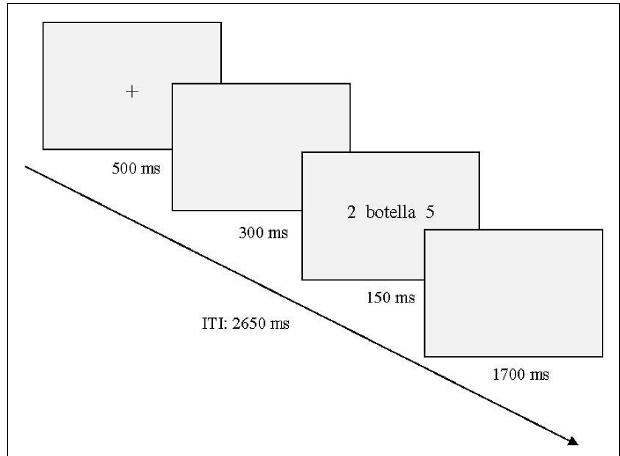
FIGURE 1 | Schematic representation of the sequence described in the main text. An example belonging to neutral words during discordant digit condition is represented (“botella” = bottle ). ITI, Intertrial